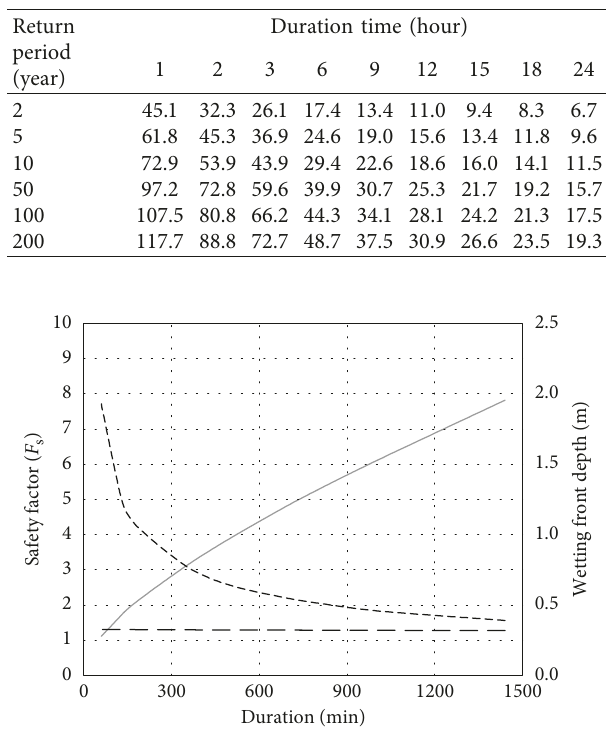
Table 3: Conditions of infiltration analysis.